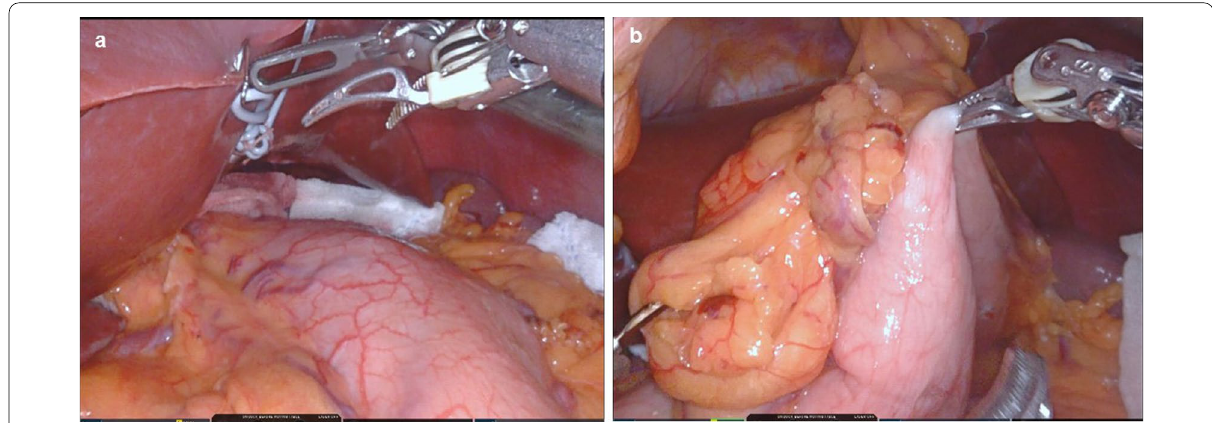
Fig. 3 Intraoperative finding. a Appearance of stomach wall, b stomach wall grasped by robotic